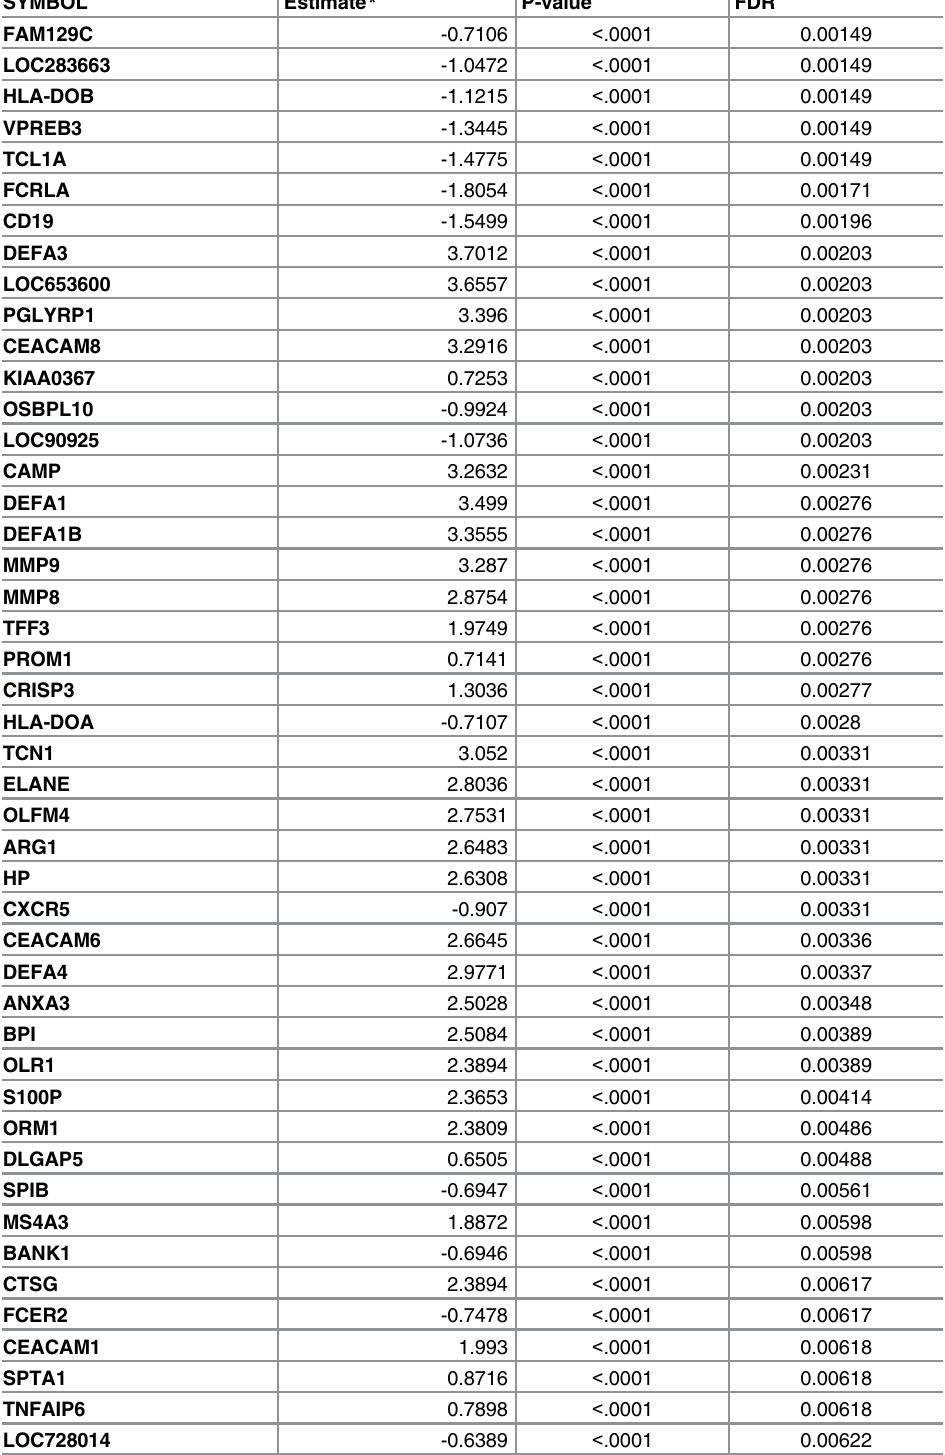
Table 2. Differentially expressed genes in PBC of breast cancer patients after the 1 st cycle of DOX- based chemotherapy versus baseline (before the start of